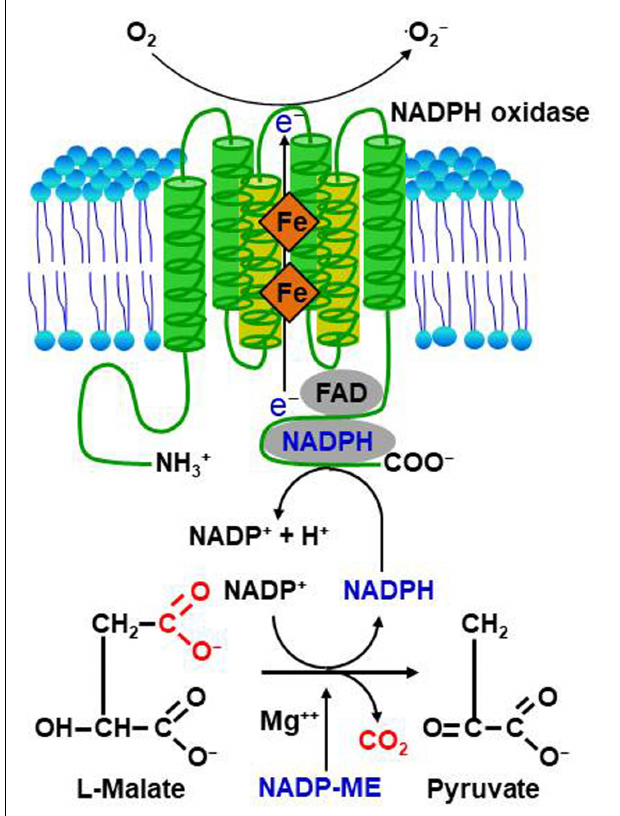
FIGURE 1 | Proposed model for NADPH oxidase-dependent ROS generation via NADP-malic enzyme (ME)-mediated electron supply. NADP-malic enzyme (ME) serves as a source of NADPH and pyruvate in the cytosol of various plant tissues. It catalyzes the oxidative decarboxylation of L-malate to yield pyruvate, CO 2 , and NADPH in the presence of a bivalent cation, such as Mg ++ . NADPH oxidase, known as the Respiratory Burst Oxidase Homolog (RBOH), catalyzes the generation of superoxide ( · O 2 − ) by the one-electron reduction of molecular oxygen using NADPH as an electron donor. Superoxide can spontaneously form hydrogen peroxide (H 2 O 2 ) that will undergo further reactions to generate reactive oxygen species